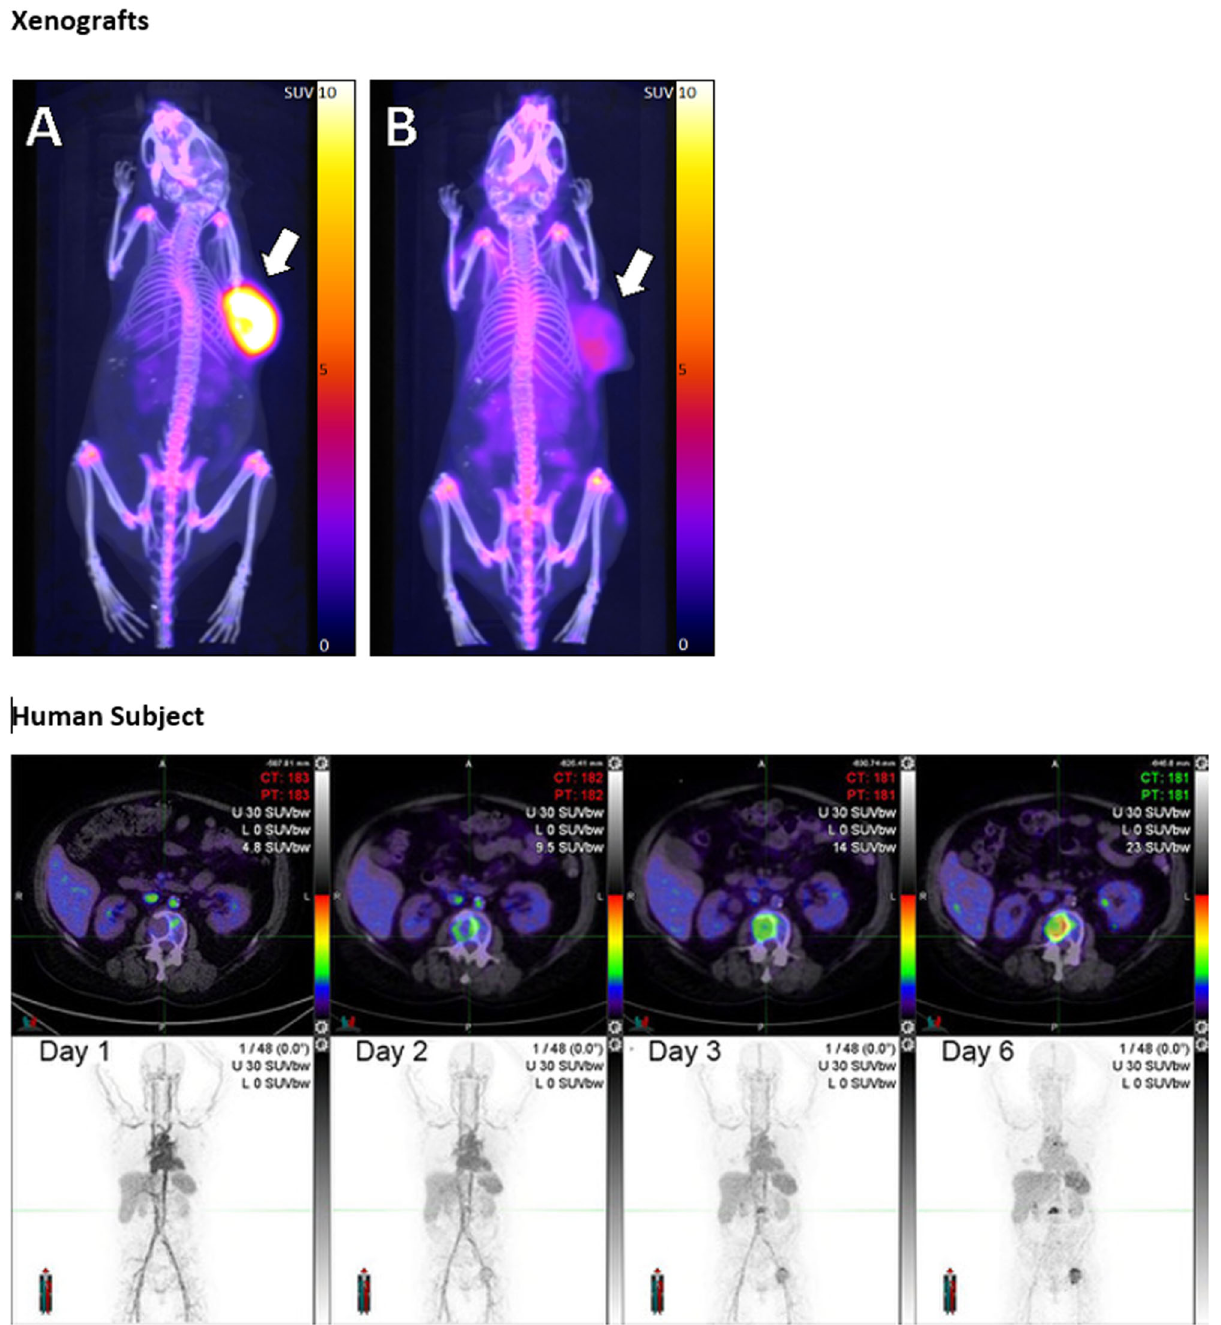
Fig. 3 Imaging PD-L1 in xenograft models and in a human subject using 89 Zr-DFO-Sq-Durvalumab PET/CT. The upper panels show 89 Zr- DFO-Sq -Durvalumab PET/CT imaging of NSG mouse bearing either HCC-827 PD-L1 high tumour (Panel A ) or a low-to-non PD-L1 expressing A549 tumour (Panel B ) at 144 h after PET tracer injection. Pseudo-coloured SUV overlays on CT scan maximum projection images are shown. Subcutaneous human tumour xenografts on right fl anks are indicated by arrows. The lower panels show the same 89 Zr-durvalumab, as validated in the xenograft model, used for PET/CT imaging in a human subject with PD-L1 positive (90%) stage IV NSCLC. Over 6 days, sequential images show gradual accumulation of tracer in distant metastases. Axial PET/CT images (upper panels) show increasingly intensi fi cation of uptake in a vertebral body metastasis. Maximum intensity projection (MIP) images (lower panels) show blood pool imaging (day 1) and then gradual accumulation in metastatic disease, including lumbar spine and left hip. (Images courtesy of Dr Tim Akhurst, Peter MacCallum Cancer